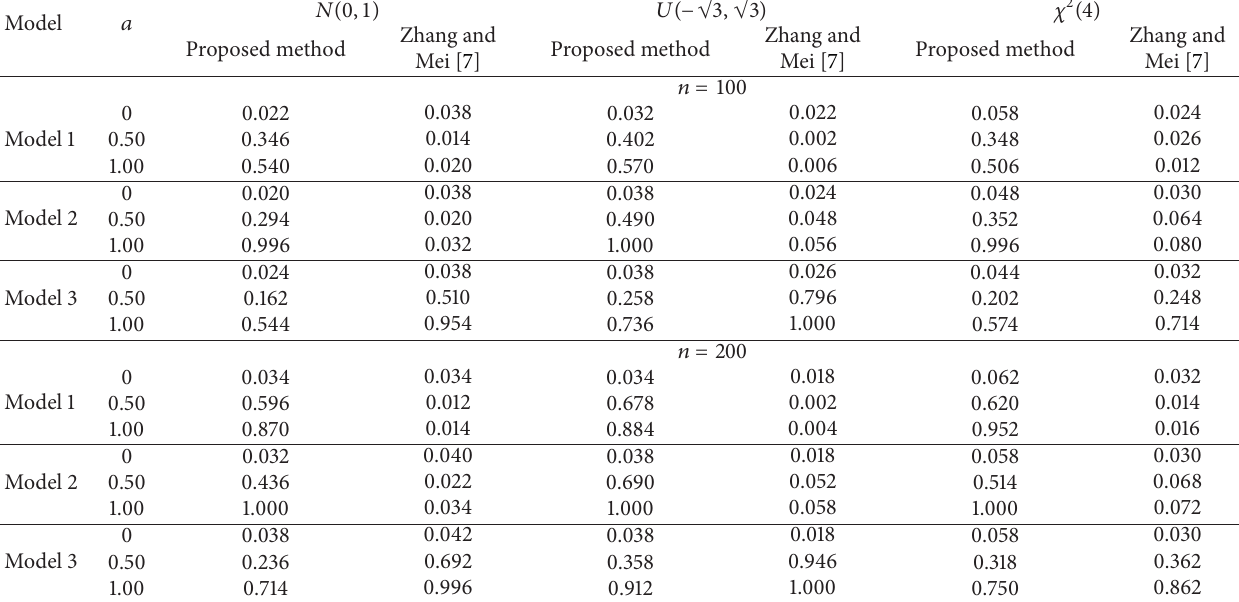
Table 1: Rejection frequencies of 500 replications of the testing